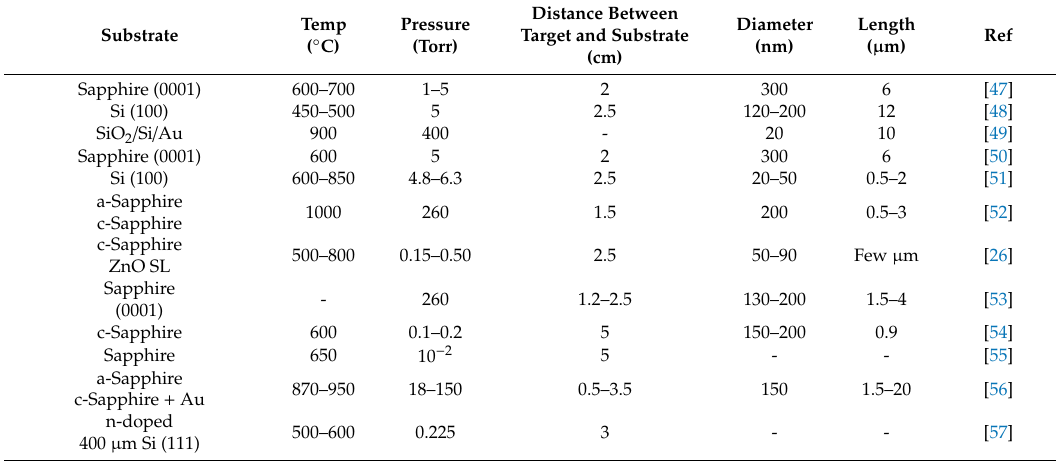
Table 1. Survey of ZnO nanowires and nanorods by pulsed laser deposition (PLD). Distance Between Temp Pressure Substrate Target and ( ◦ C) (Torr)